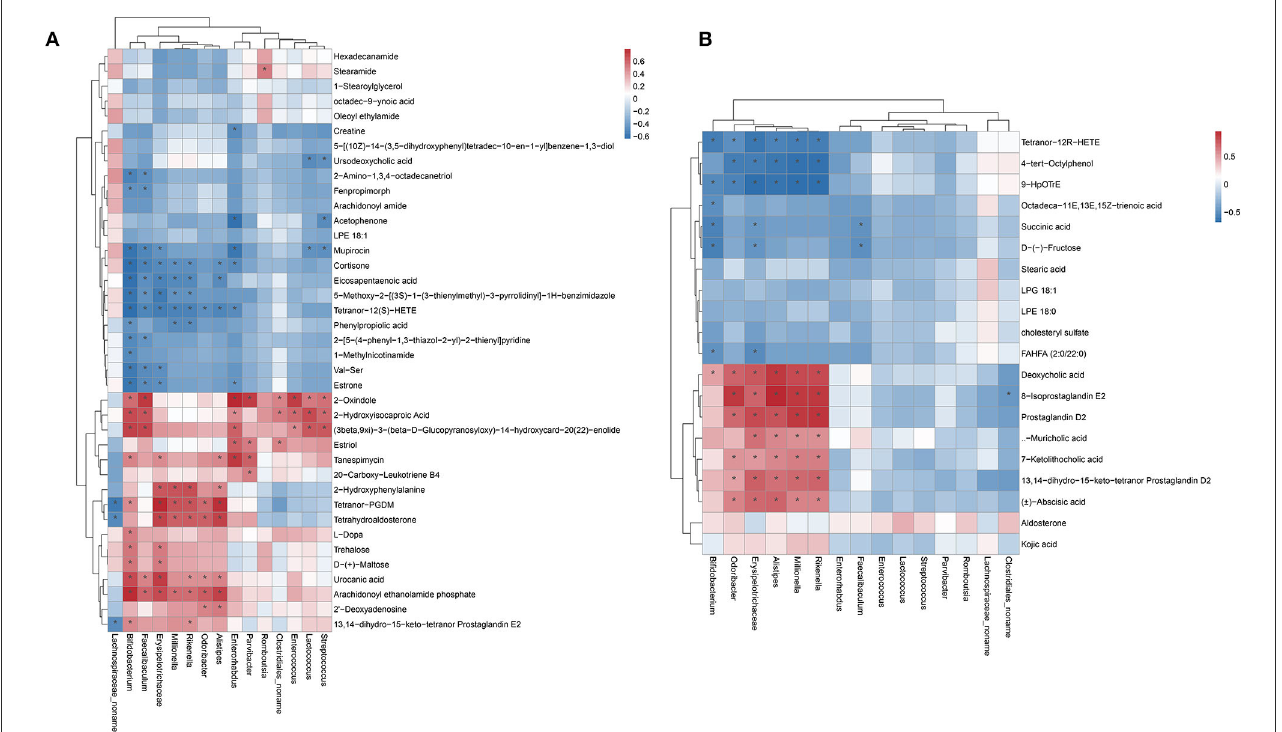
FIGURE6 Heatmap showing the Pearson correlation analysis between the gut microbiota and metabolites. (A) positive ion mode. (B) negative ion mode.